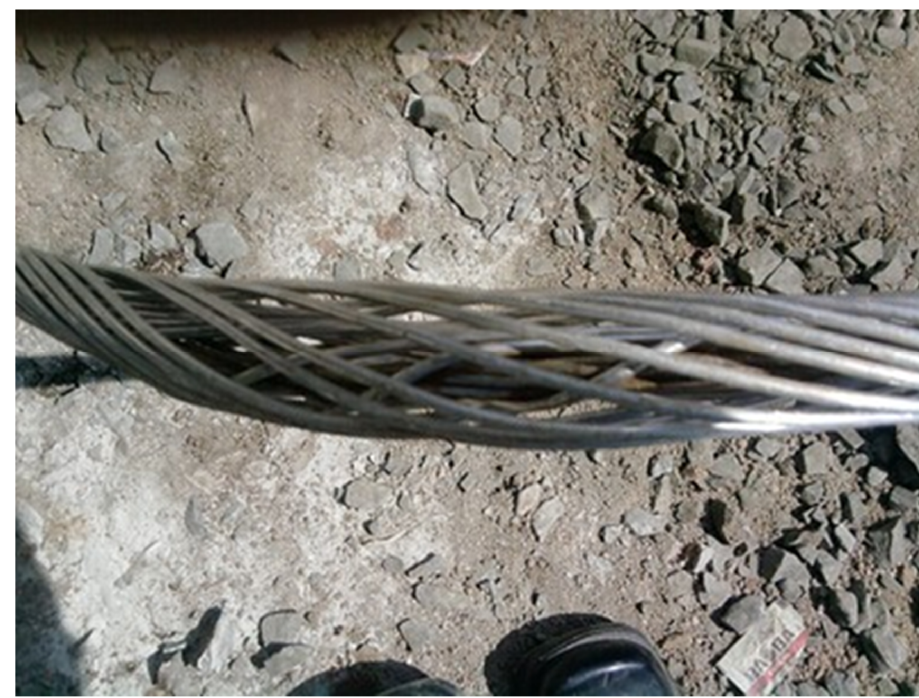
Figure 9. Bird caging in transmission conductor [90]. Table 3. Summary of transmission grid challenges and control.